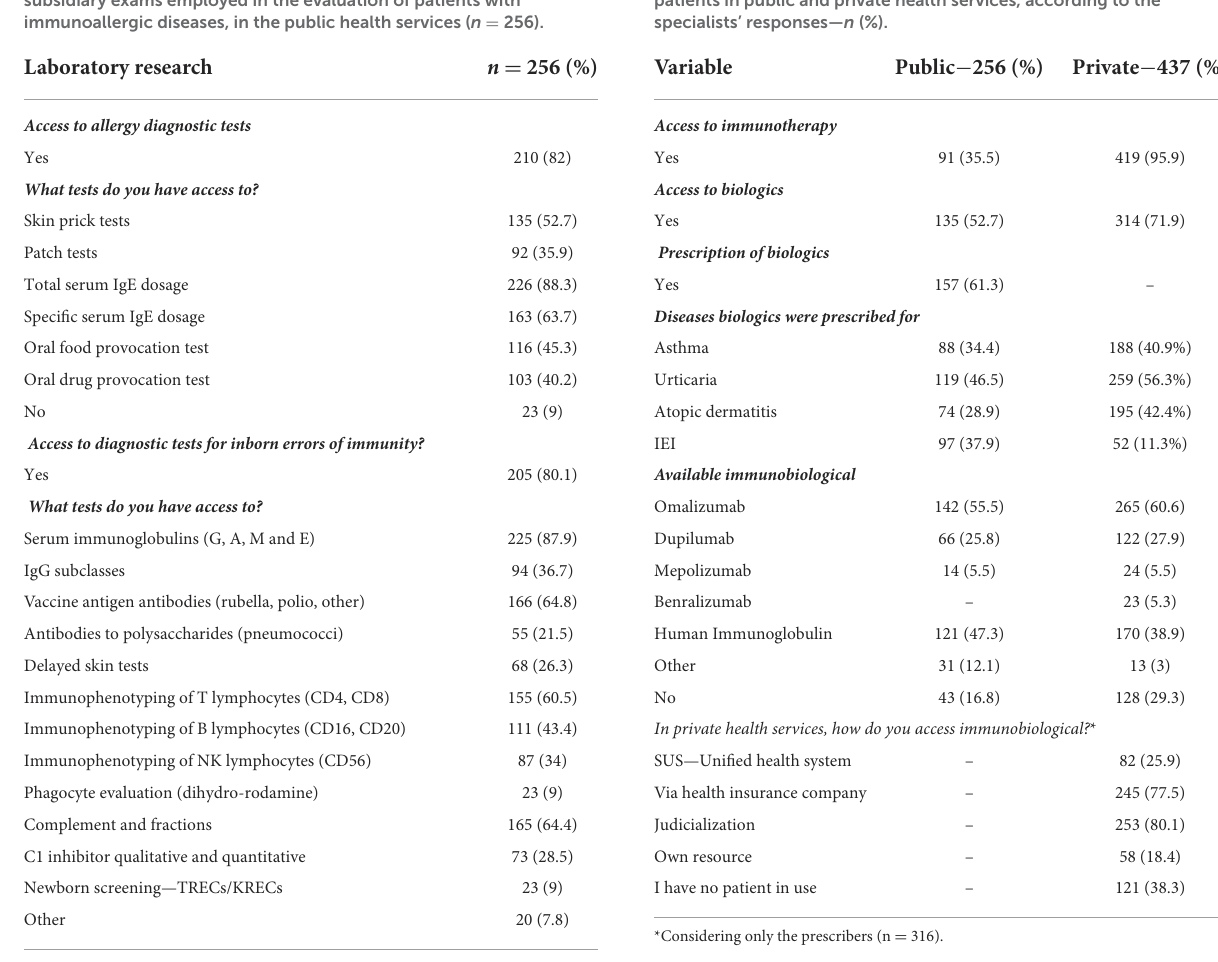
TABLE 2 Distribution of specialists according to the availability of subsidiary exams employed in the evaluation of patients with immunoallergic diseases, in the public health services ( n = 256).